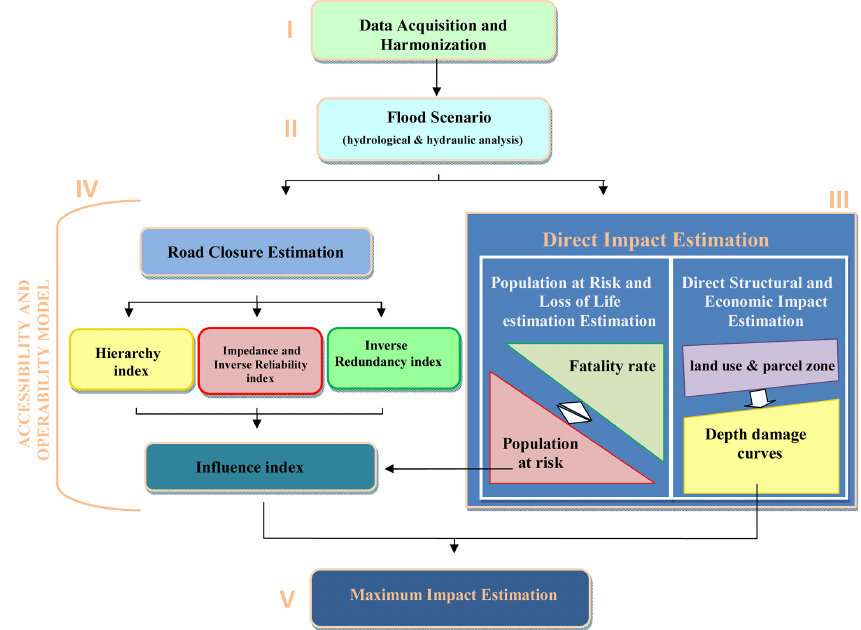
Figure 1. Phases of the proposed